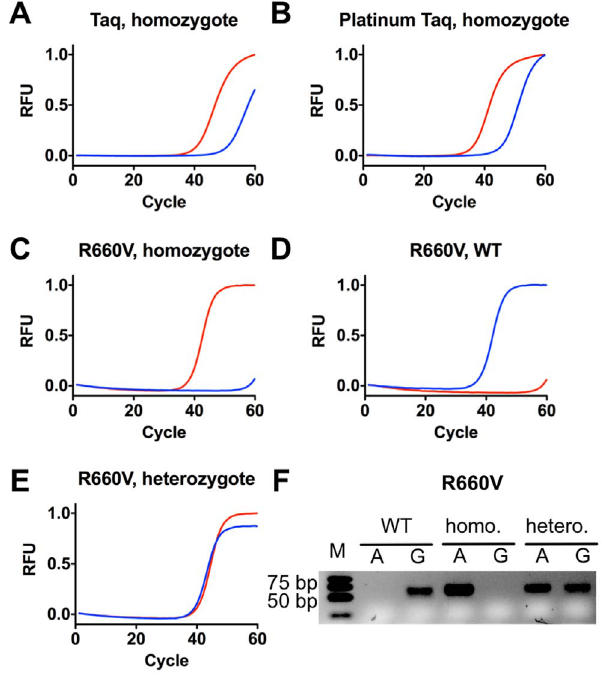
Figure 4. ASA assay of Factor II prothrombin, Human gDNA (WHO International Standards) with R660V mutant. Allele- specific primers A and G result in a 3 end match or mismatch depending on the chosen template. In red primer A is shown, in blue primer G. RFU = relative fluorescence units. A) ASA real time PCR curves of Factor II homogygote (genotype A/A) using Taq DNA polymerase, B) Platinum Taq DNA polymerase, or C) mutant R660V. D) ASA real time PCR curves of Factor II wild-type (genotype G/G), E) ASA real time PCR curves of Factor II heterozygote (genotype G/A), F) Agarose gel electrophoresis analysis of ASA PCR. M = Marker, A = Primer A, G = Primer G, wild-type (WT) indicates the used wild-type template, homo, the homozygote and hetero, the heterozygote template.